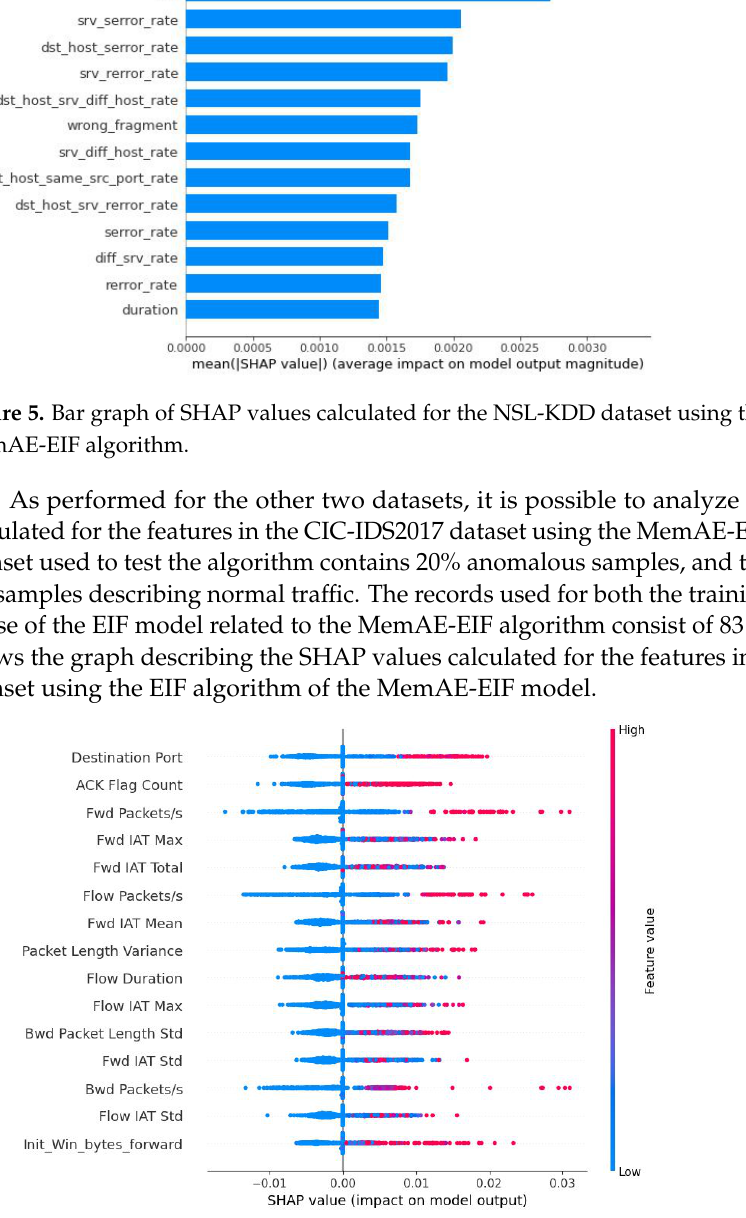
Figure 6. Summary plot of SHAP values calculated for the CIC-IDS2017 dataset using the EIF model of the MemAE-EIF